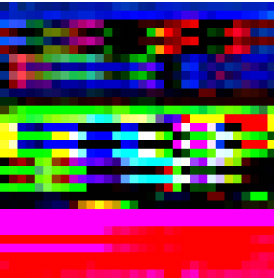
Figure 2. An RGB illustration of a three-channel image consisting of motion